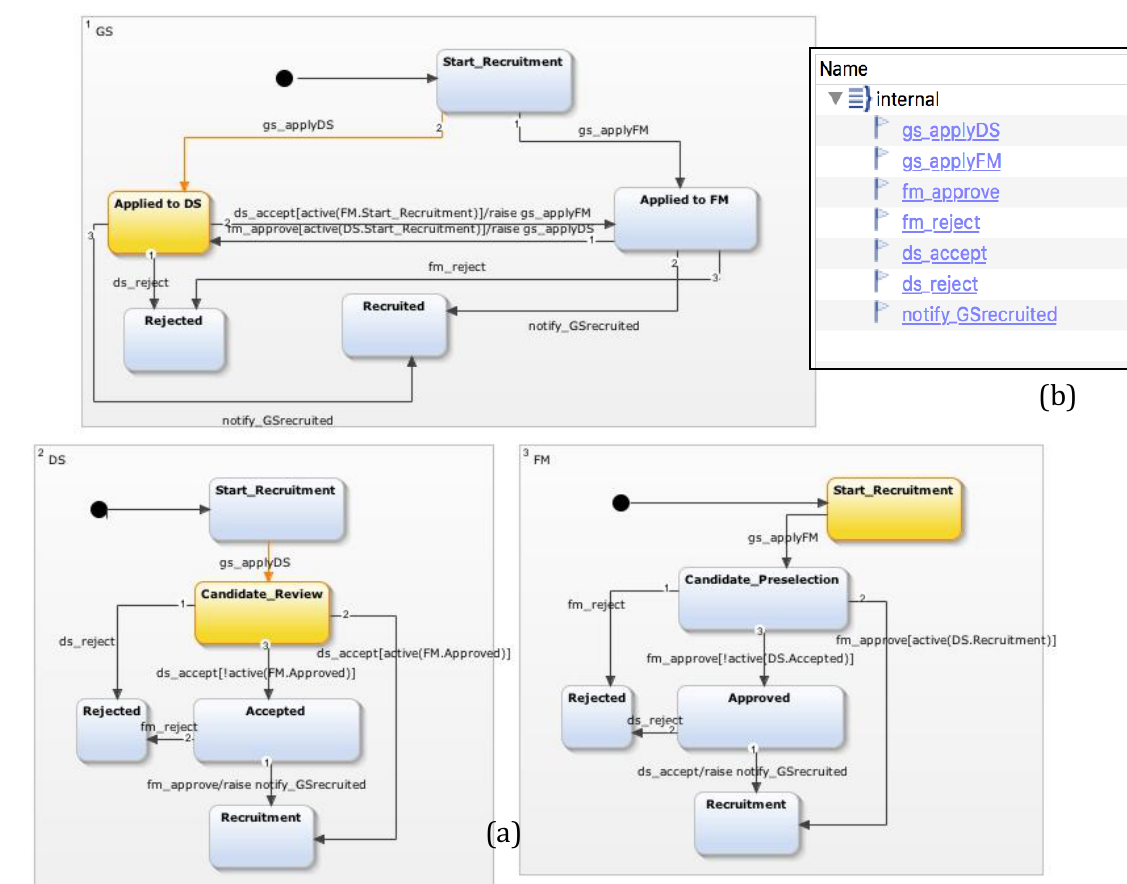
Figure 5. Simulation of the operational model with YAKINDU: (a) represents the three concurrent state machines and (b) shows the events sent by the person running the simulation (i.e. the actual decisions taken by the three